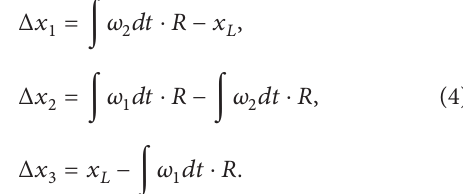
where Δ𝑥 1 , Δ𝑥 2 , and Δ𝑥 3 are the elongations of each segment of rope while the vehicle moves and 𝑥 𝐿 is the distance of vehicle.